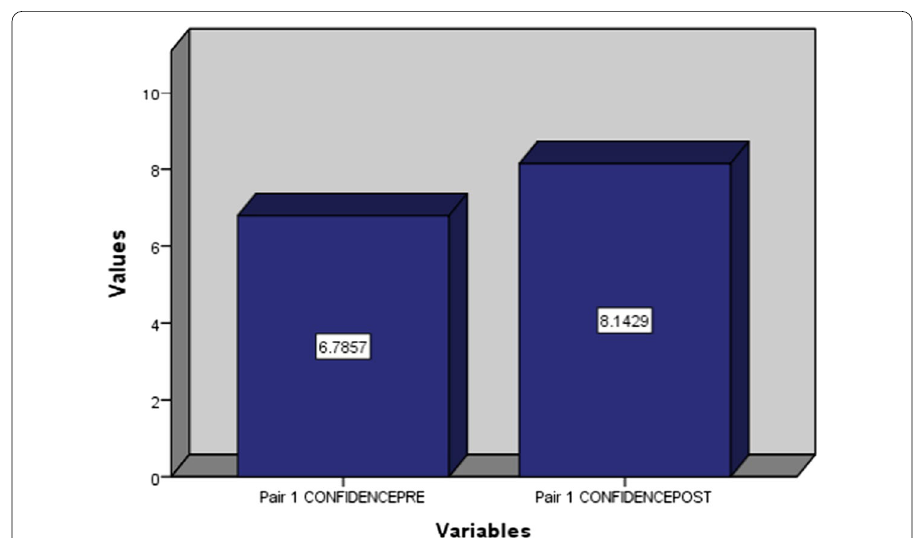
Fig. 5 Paired samples statistics: confidence. Source: SPSS 23.0 output